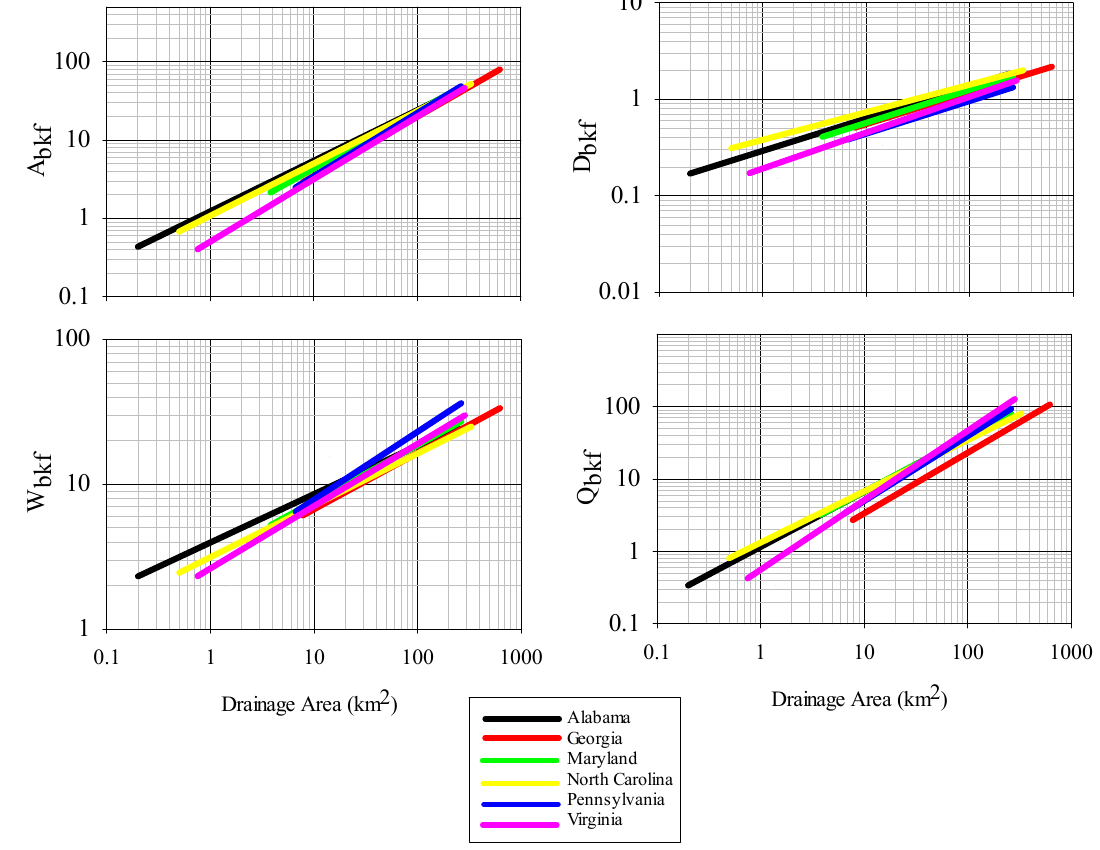
Figure 4. Comparison of regional geomorphic curves across the Piedmont ecoregion of the southeast.